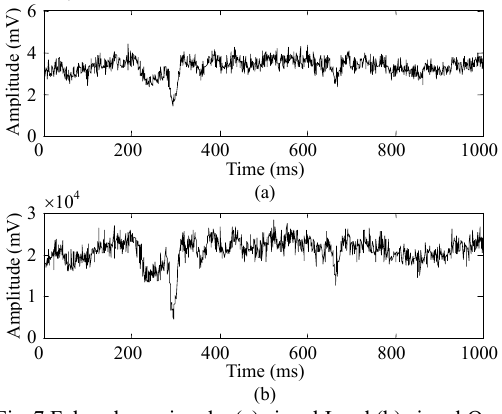
Fig. 7 False alarm signals: (a) signal I and (b) signal Q. Table 3: Statistic on false alarm